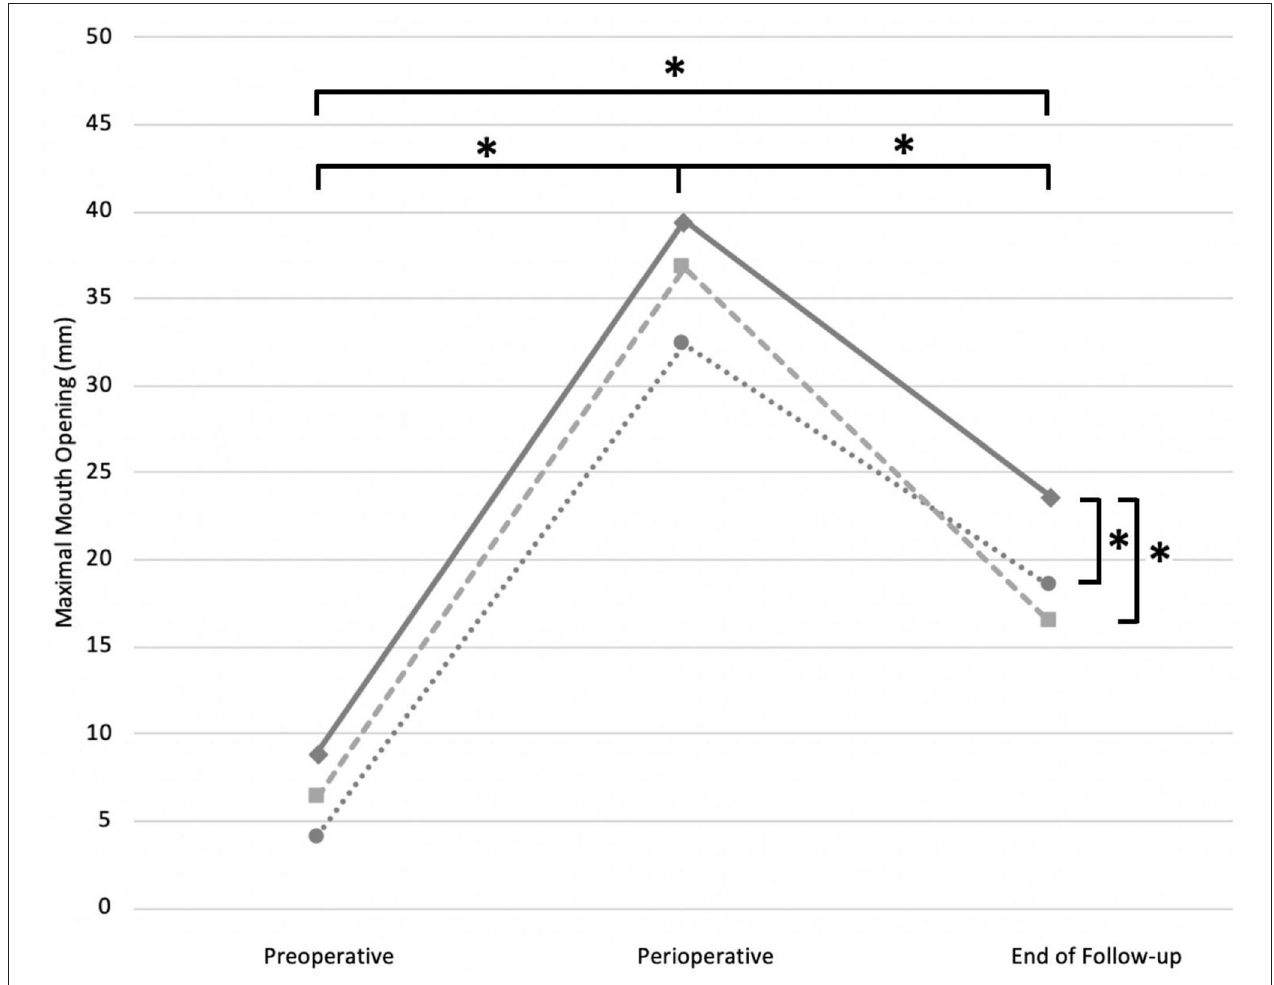
FIGURE 2 | Estimated marginal means preoperative, perioperative and at the end of FU described for each surgical intervention strategy, when performed alone or in combination with one of the two strategies. Solid line, CN; dotted line, MT; striped line, FFR. *, P -value < 0.05 was set as statistically